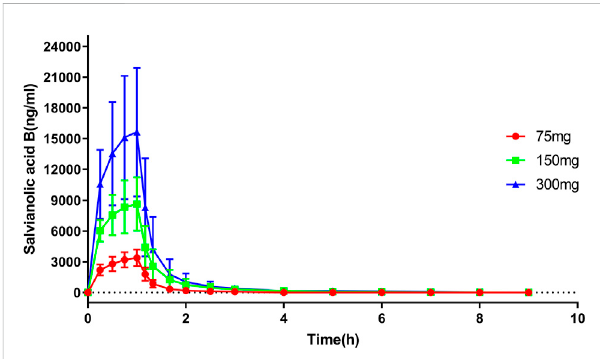
FIGURE 2 Plasma concentration – time pro fi le of salvianolic B in the SAD study. n = 8. Data are presented as the mean ±